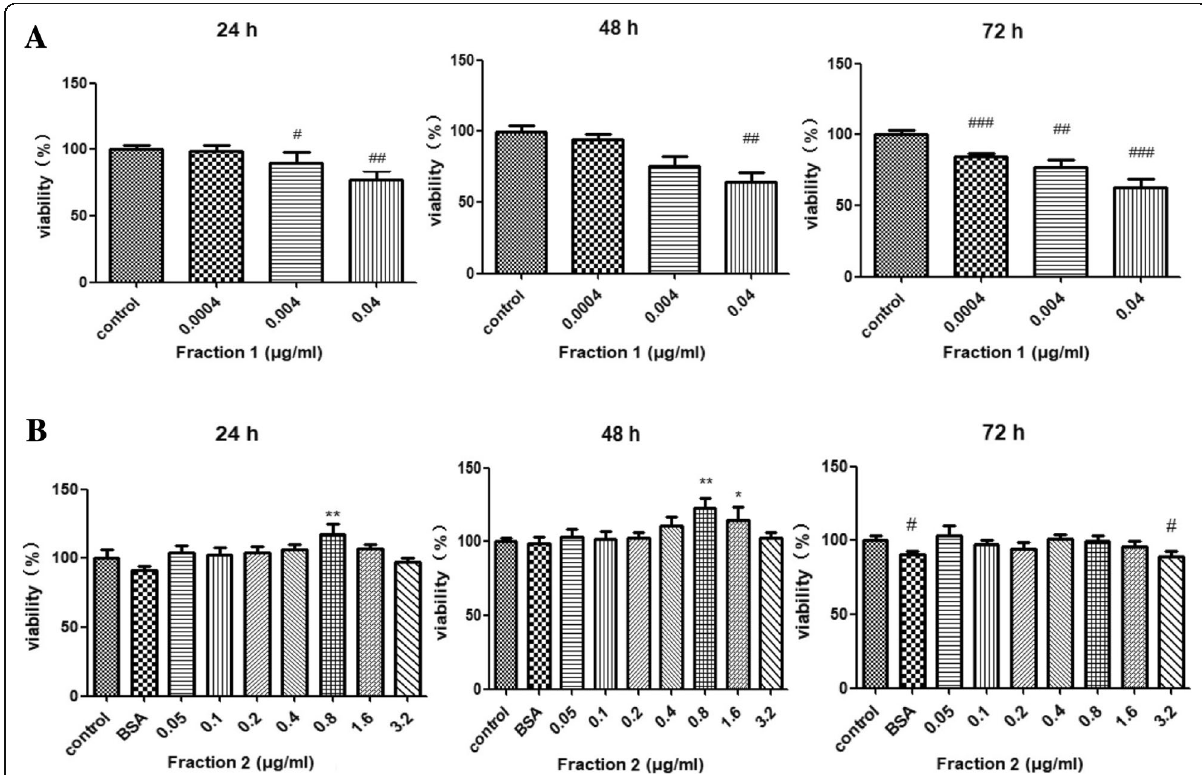
Fig. 2 Proliferative effects of protein fractions on human epidermal keratinocytes (HaCaT) after incubation for 24 h, 48 h or 72 h, as evaluated by MTT assays. a Proliferative effects of Fraction 1 on HaCaT cells. b Proliferative effects of Fraction 2 on HaCaT cells. Results are expressed as the mean ± SEM of at least seven determinations for each test from three independent experiments. Statistical significance of differences: *, p < 0.05; **, p < 0.01; ***, p < 0.001; #, p < 0.05; ##, p < 0.01; ###, p < 0.001 (* and # indicate comparisons with control conditions for proliferative and cytotoxic effects, respectively). BSA, bovine serum albumin, 3.2 μ